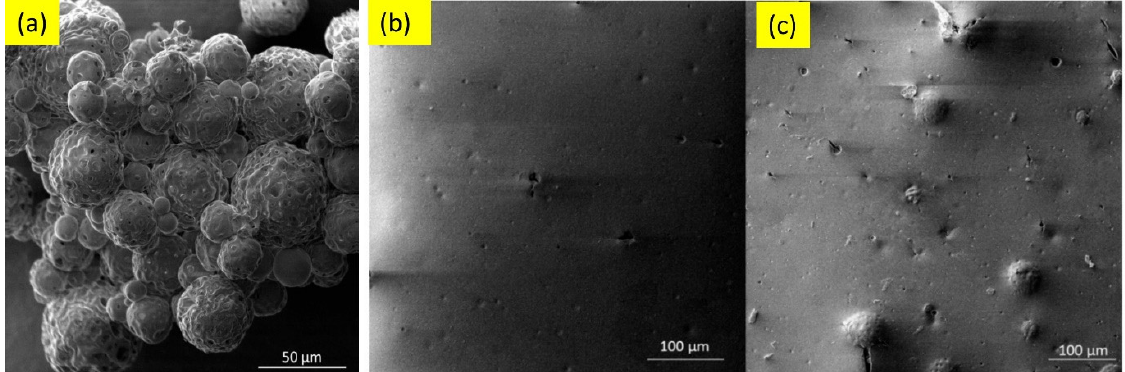
Figure 8. Potentiodynamic curves with acrylic coating doped with colophony microcapsules depos- ited on mild steel in ( a ) DI water (pH 6.8) and ( b ) SCPS (pH 12.6) [127].